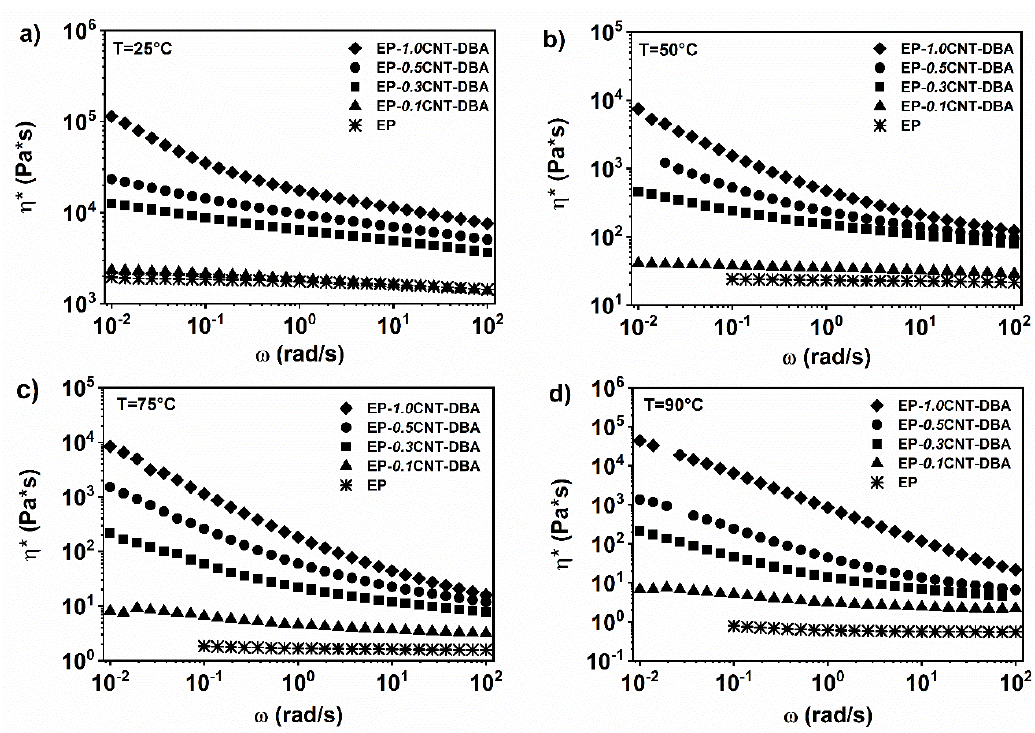
Figure 8. Complex viscosity ( η *) vs. frequency ( ω ) for EP-DBA with a different concentration of CNT at: ( a ) T = 25 °C; ( b ) T = 50 °C; ( c ) T = 75 °C; ( d ) T = 90 °C.